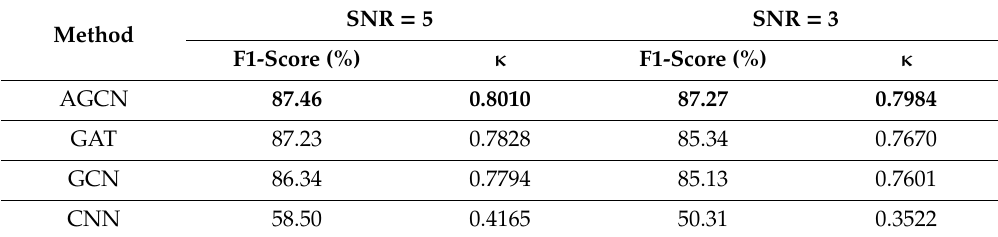
Table 8. Comparison segmentation performance of four methods for different SNR values.